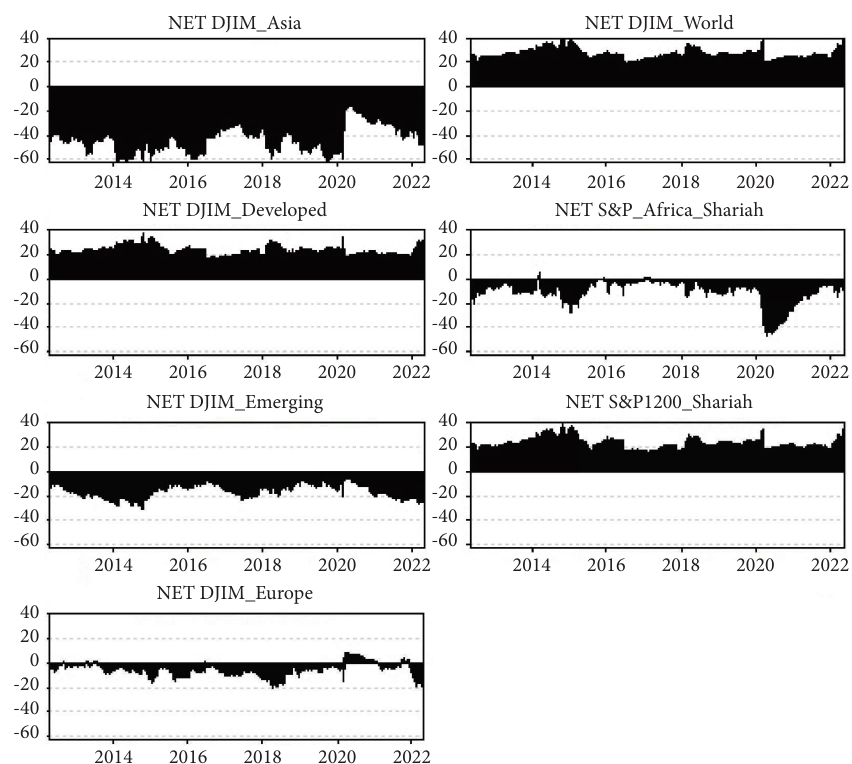
Figure 5: Directional and net spillovers between regional Shariah markets. Notes: the dynamic directional (“TO” and “FROM”) and net pairwise spillover dynamics between regional Shariah markets is